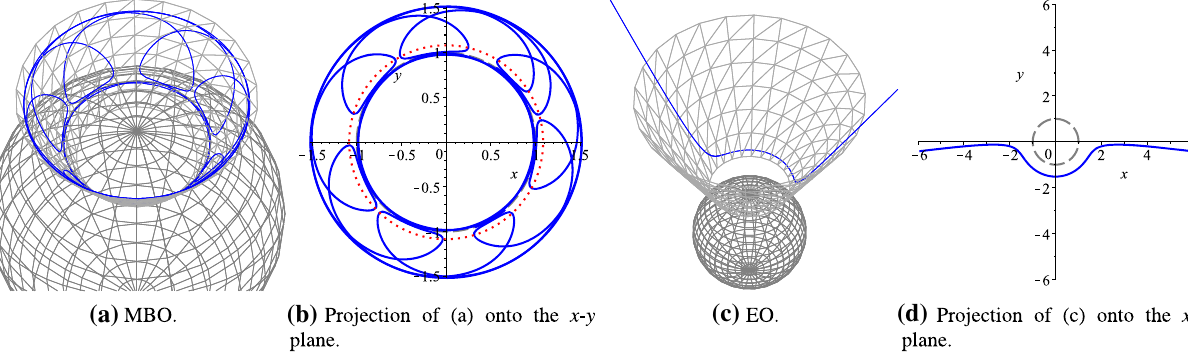
Fig. 9 MBO and EO for parameters K = 0 , L = 8 , δ = 0 , l = 1 , J = 4, and energy E = 0 . 343913. The trajectory lies on a cone with opening angle θ < π/ 2. In b the dotted circle indicates the φ turning points. The spheres and dashed circles show the horizon at R = 1